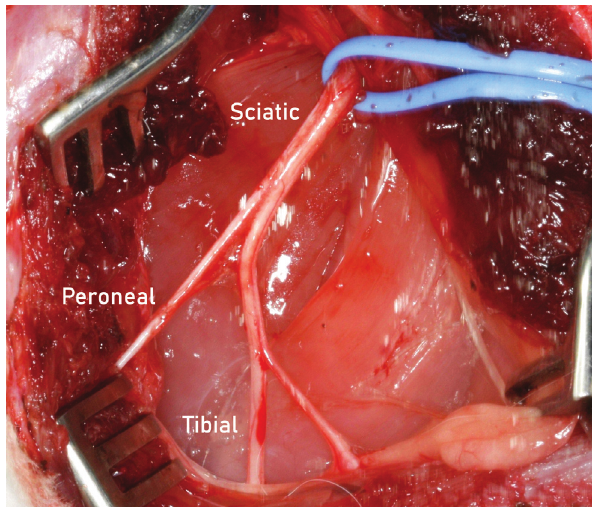
Fig. 1 Anatomy of the rabbit sciatic nerve. The sciatic nerve divides into its main branches the peroneal nerve and the tibial nerve. The tibial nerve is the largest branch and gives rise to the sural nerve branch at midthigh level.